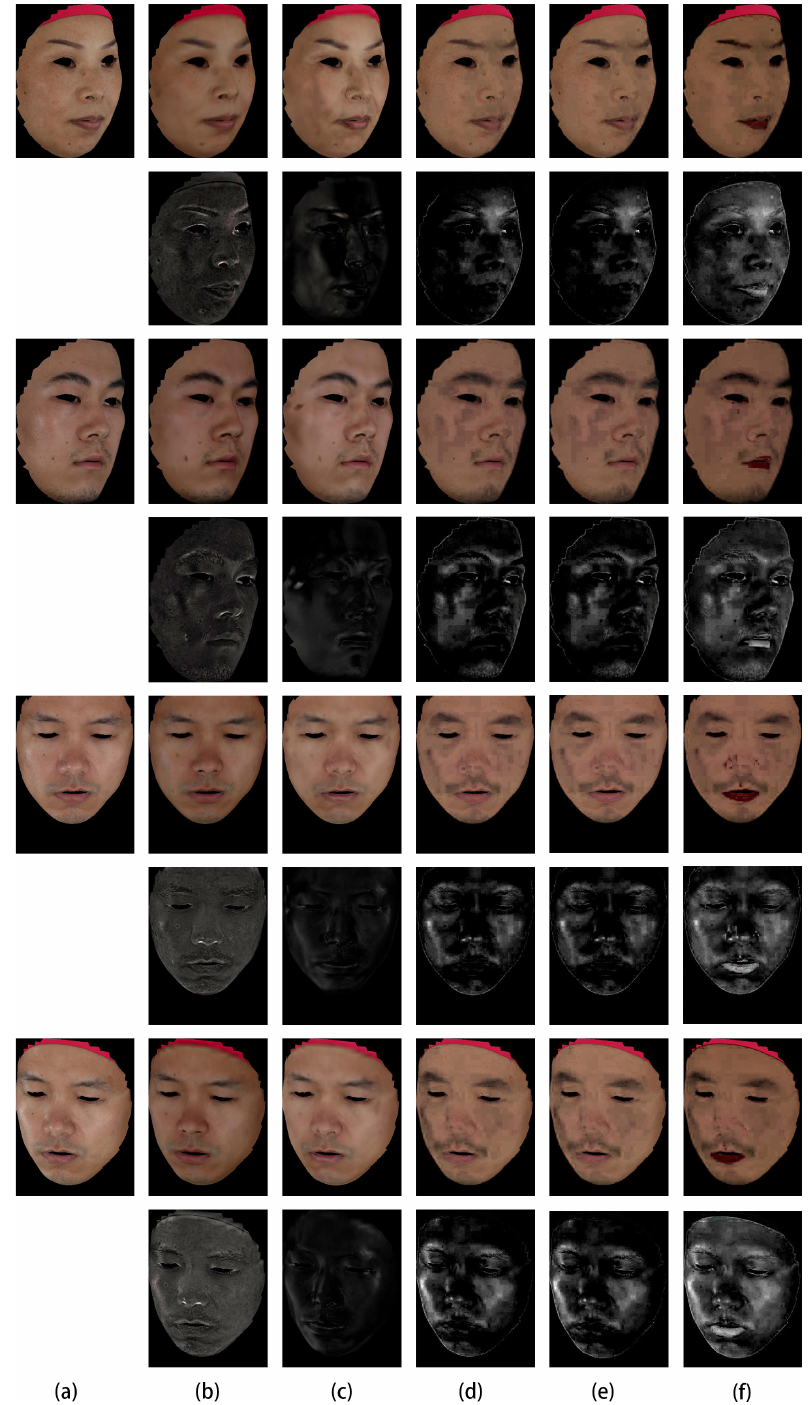
Figure 5. Qualitative evaluation of highlight removal on FaceScape Dataset. ( a ) Input images. ( b – f ) Separated diffuse and specular components by ( b ) our method based on dichromatic reflection model, ( c ) our method based on mirror reflection model, ( d ) [58], ( e ) [59], and ( f ) [29]. The specular component is rescaled by two for better